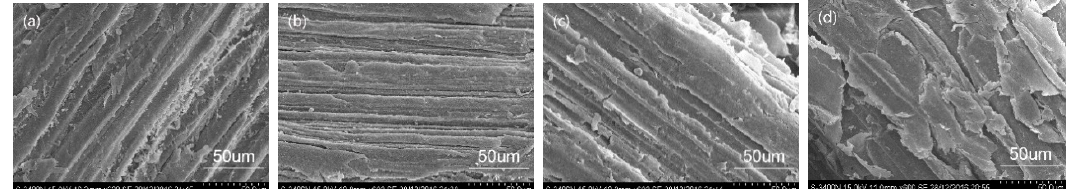
Figure 3. Scanning electron microscopy (SEM)morphology of BF modified by various methods: ( a ) untreated BF (UBF); ( b ) alkali treated BF (ABF); ( c ) BF modified by silane coupling agent (SBF); ( d ) BF modified combining alkali treatment with silane coupling agent (ASBF).